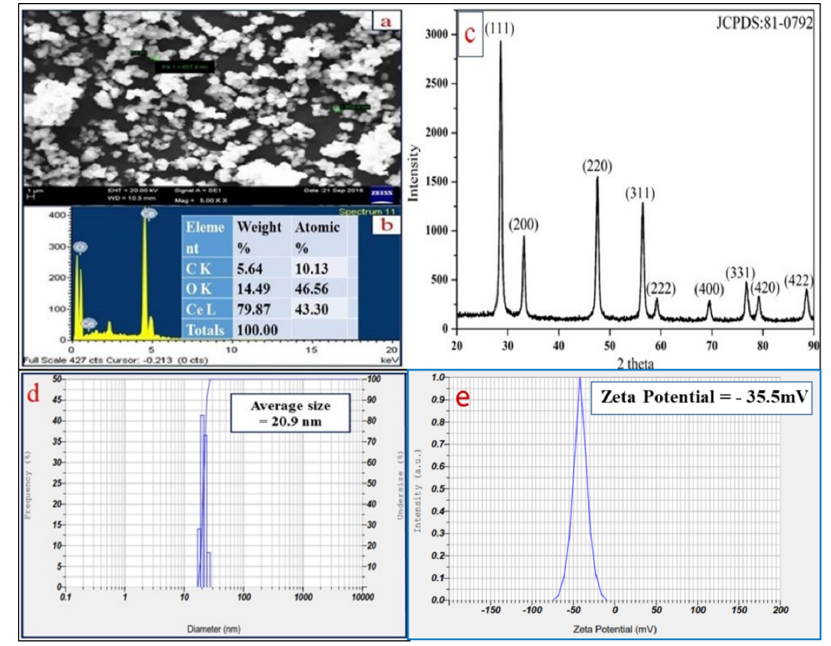
Figure 3. ( a ) SEM image of CeO 2 NPs, ( b ) EDAX spectrum, ( c ) XRD di ff ractogram of synthesized CeO 2 Figure 3. (a) SEM image of CeO 2 NPs, (b) EDAX spectrum, (c) XRD diffractogram of synthesized NPs, ( d ) particle size distribution, and ( e ) Zeta potential of CeO 2 CeO 2 NPs, (d) particle size distribution, and (e) Zeta potential of CeO 2 NPs.